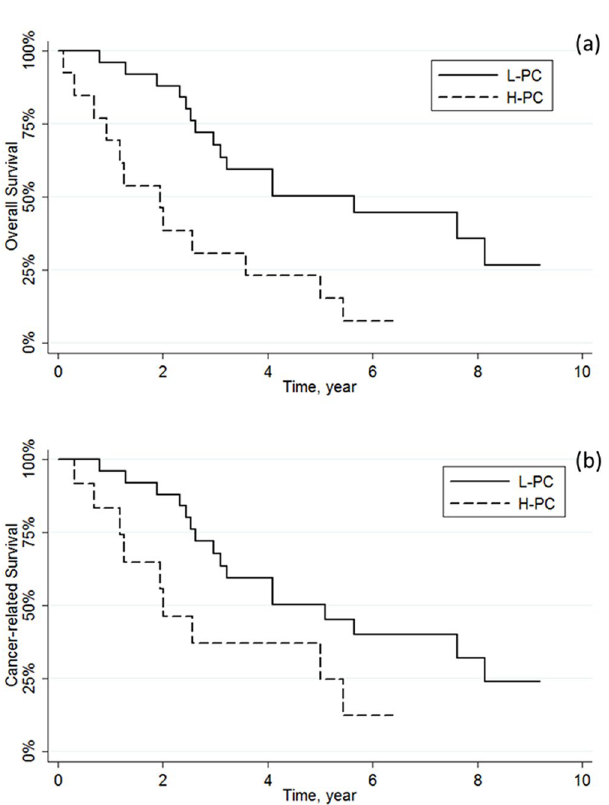
Figure 3. Kaplan-Meier curves for ( a ) overall survival (p = 0.002) and ( b ) cancer-related survival (p = 0.041) stratified by PC in AJCC/UICC TNM Stage